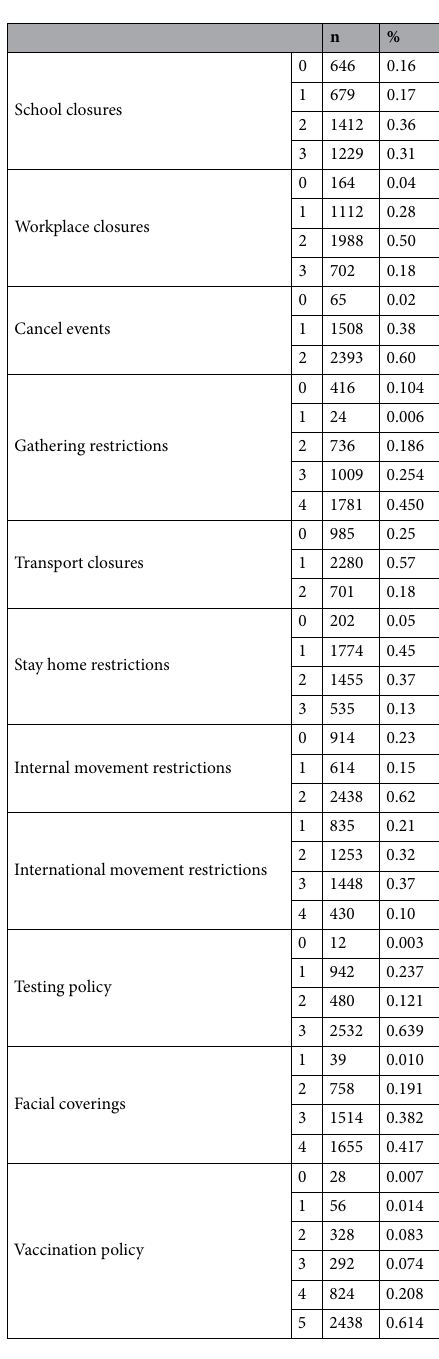
Table 2. Distributions of policy situations for all countries between 15.03.2021 and